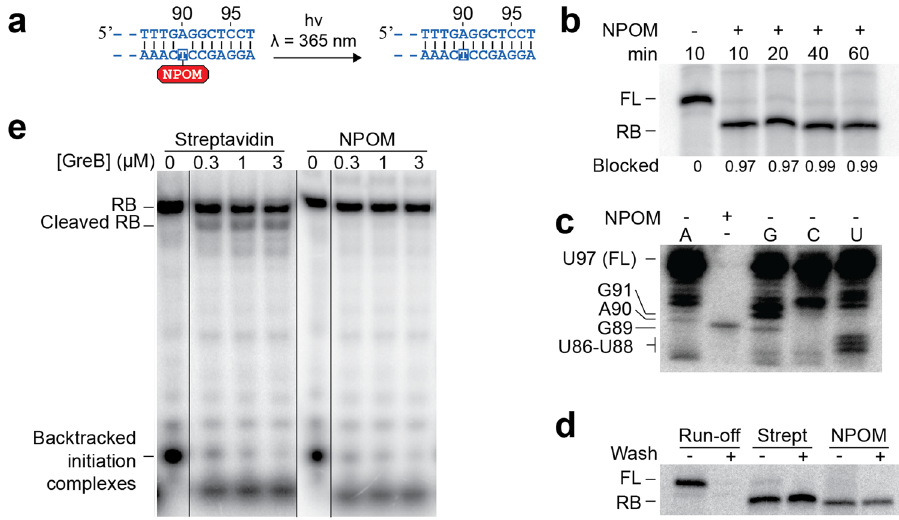
Fig. 2 Characterization of NPOM as a transcriptional roadblock. a Schematic representation of the DNA template used for the characterization of NPOM as a transcriptional roadblock. Only the 3 ′ extremity of the template is shown. NPOM-dT has been incorporated on the template strand at the 90th position. Upon UVA exposure, NPOM is cleaved, thus yielding an unmodi fi ed dT. b In vitro transcription experiments performed in the absence ( − ) or presence ( + ) or NPOM. Transcription was allowed to proceed for indicated amounts of time. The full-length (FL) and roadblocked (RB) species are shown. c Mapping of NPOM-roadblocked transcripts using 3 ′ -OMe RNA sequencing reactions. The 3 ′ -OMe nucleotide is shown above each lane and the nucleotide sequence is shown on the left. d Transcription assays performed in presence of streptavidin and NPOM roadblocks that were treated without ( − ) and with ( + ) washing steps. ECs were bound to Ni-NTA agarose beads for washing steps. Run-off transcription was used as a negative control. e NPOM-roadblocked and biotin/streptavidin-roadblocked ECs were subjected to GreB before and after UV irradiation. As a positive control, internal biotin/streptavidin roadblocked templates were used 31 . Roadblock (RB) and cleaved roadblock transcripts (cleaved RB) are shown on the left. The experiments were performed at least two times and variations were less than